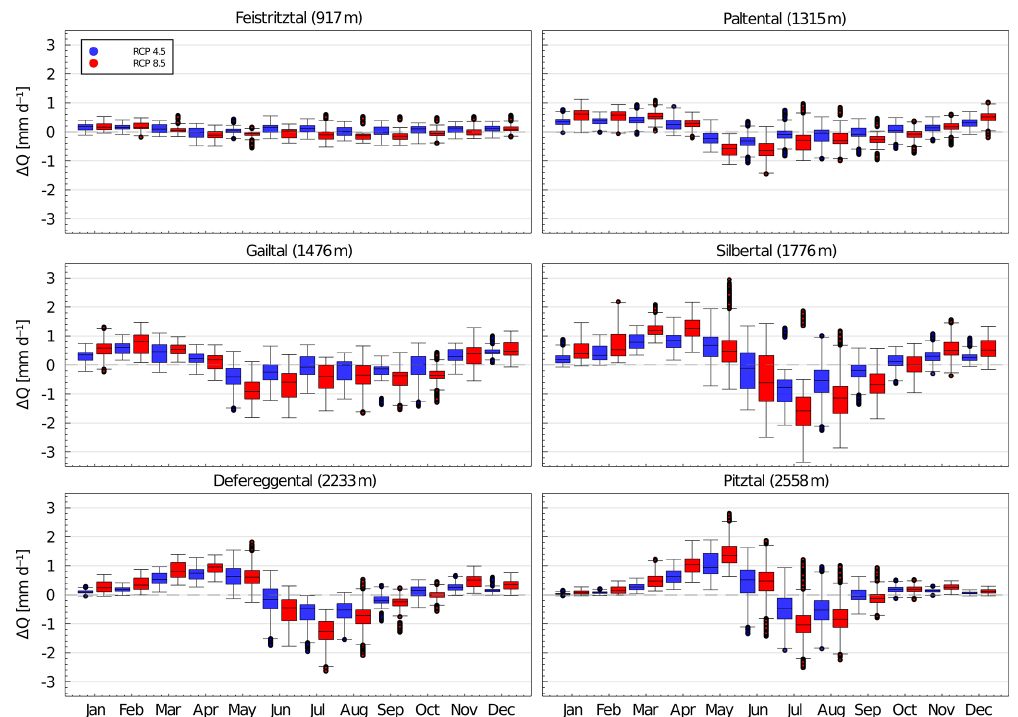
Figure 9. Absolute changes in future mean monthly runoff ( (cid:49)Q ) across all simulations per RCP for the six study catchments. Mean catch- ment elevation is given in parentheses.